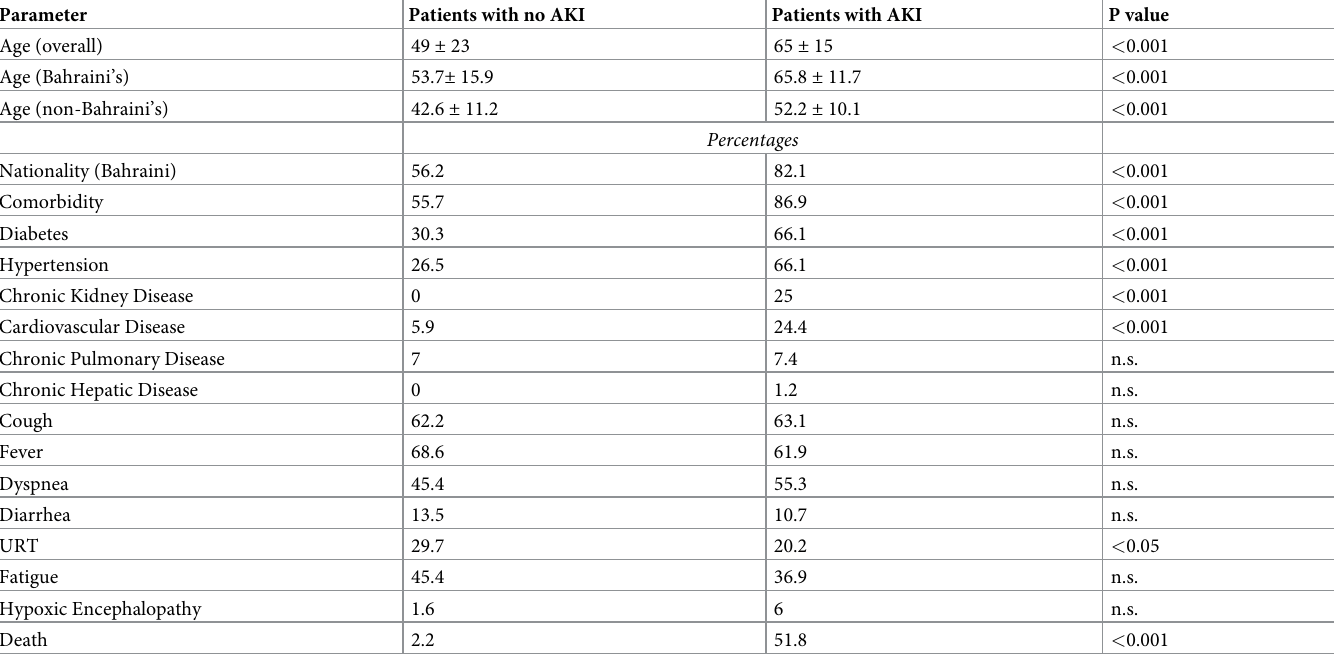
Table 1. Characteristics and medical conditions of the study